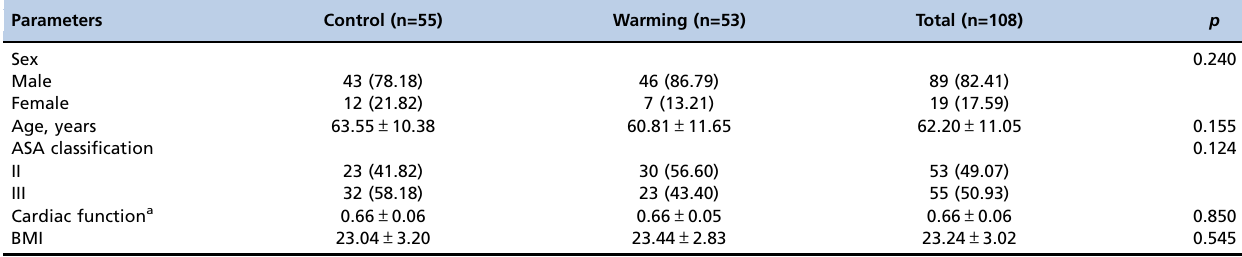
Table 1 - Demographic and clinical characteristics.